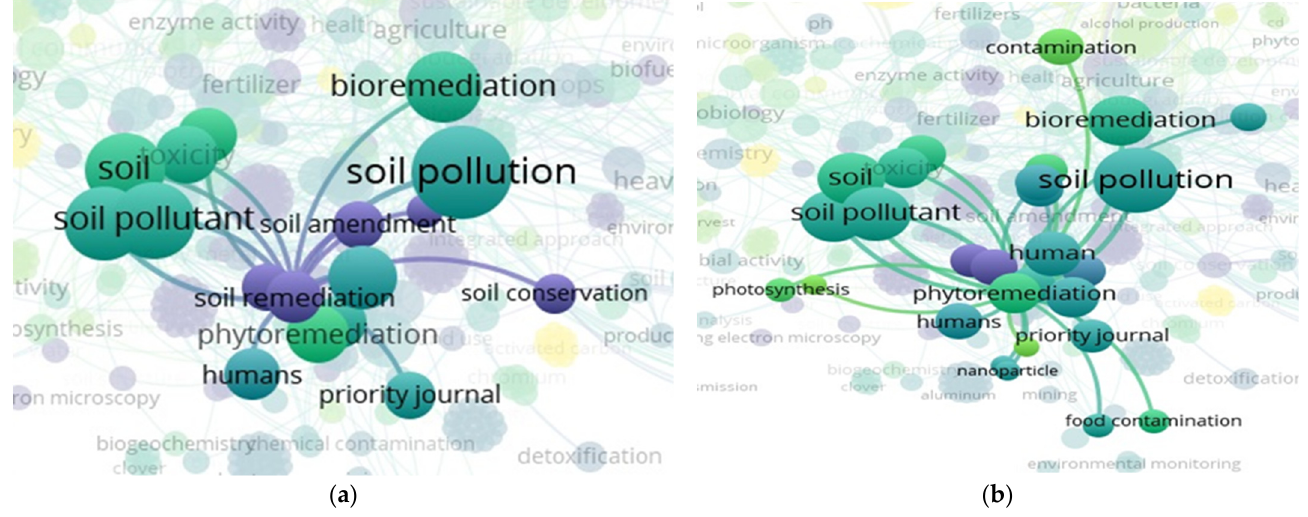
Figure 10. Analyzing Scopus results with the VOSviewer. The soil remediation ( a ) and phytoreme- diation ( b ) paradigms.